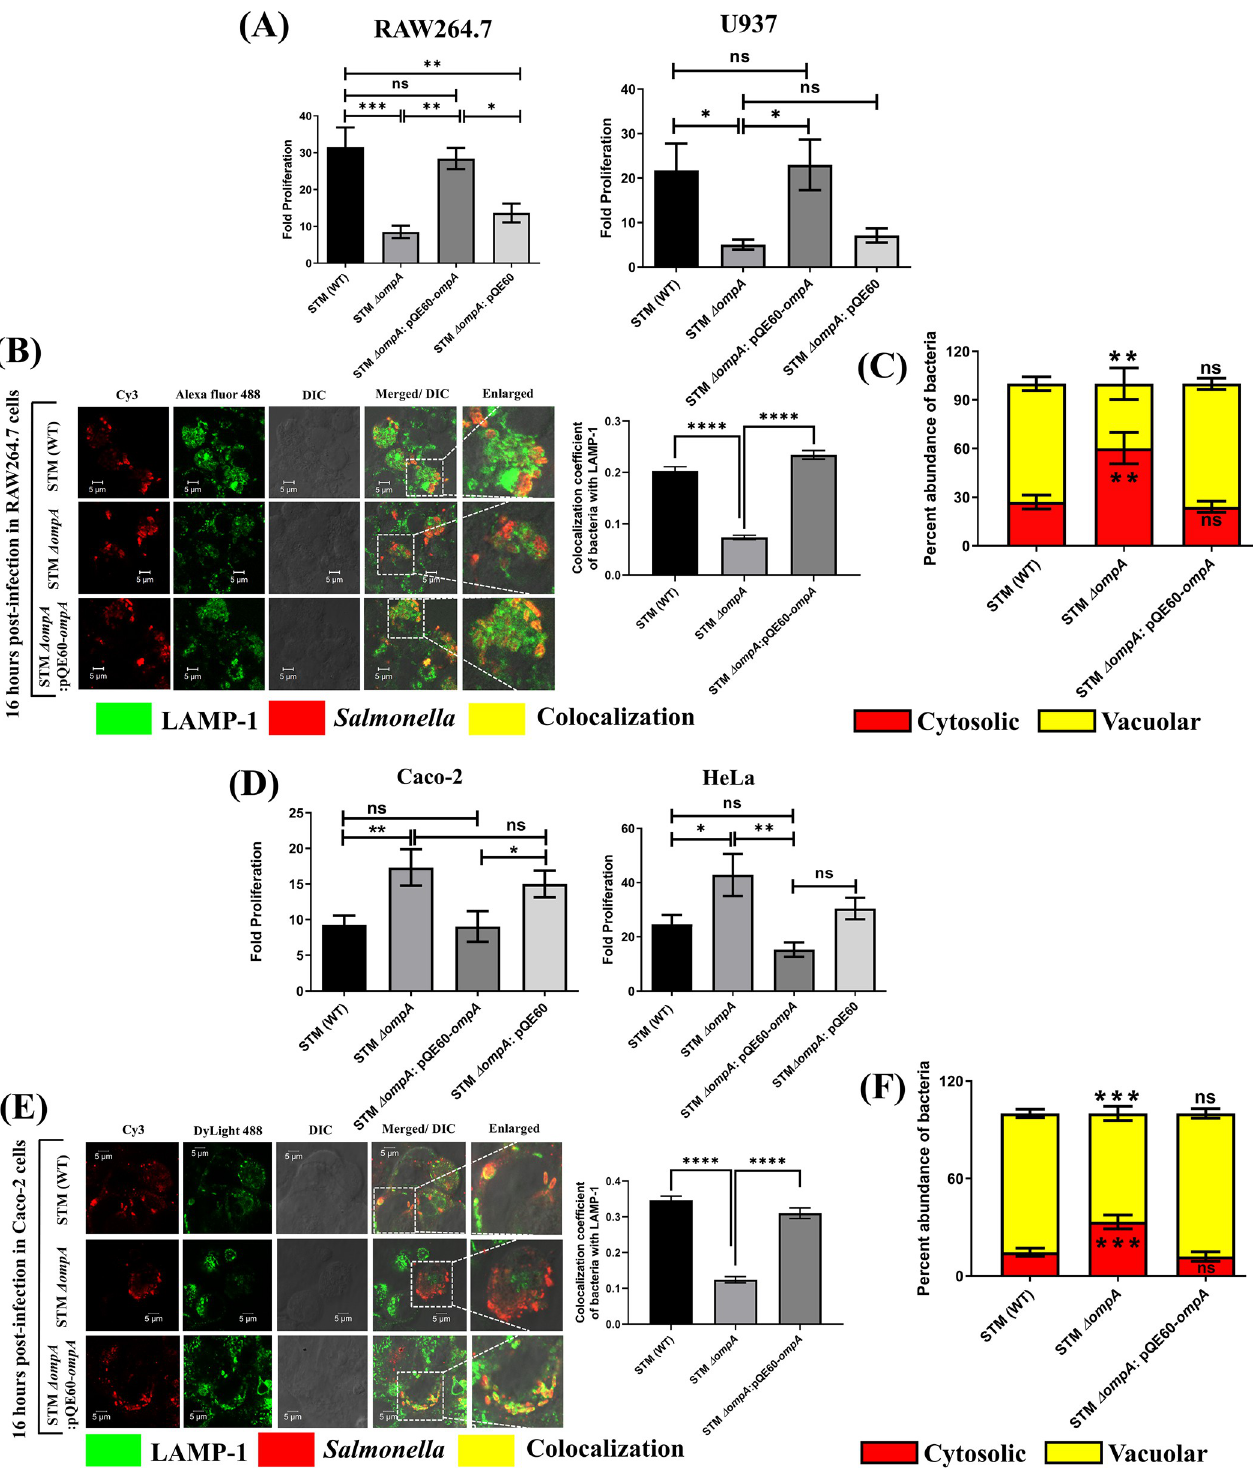
Fig 1. Deletion of OmpA impairs the intracellular proliferation of Salmonella Typhimurium in macrophages. (A) Fold proliferation of STM (WT), Δ ompA , Δ ompA : pQE60- ompA , & Δ ompA : pQE60 in RAW264.7 and PMA activated U937 cells (MOI = 10) (n = 3, N = 3 for RAW 264.7 cells and n = 3, N = 2 for activated U937 cells). (B) Representative image of LAMP-1 recruitment on STM (WT), Δ ompA , and Δ ompA : pQE60- ompA (MOI = 20) in RAW264.7 cells. The colocalization coefficient of the bacteria with LAMP-1 has been represented in the form of a vertical bar graph. Scale bar = 5 μ m (n = 100, N = 4). (C)